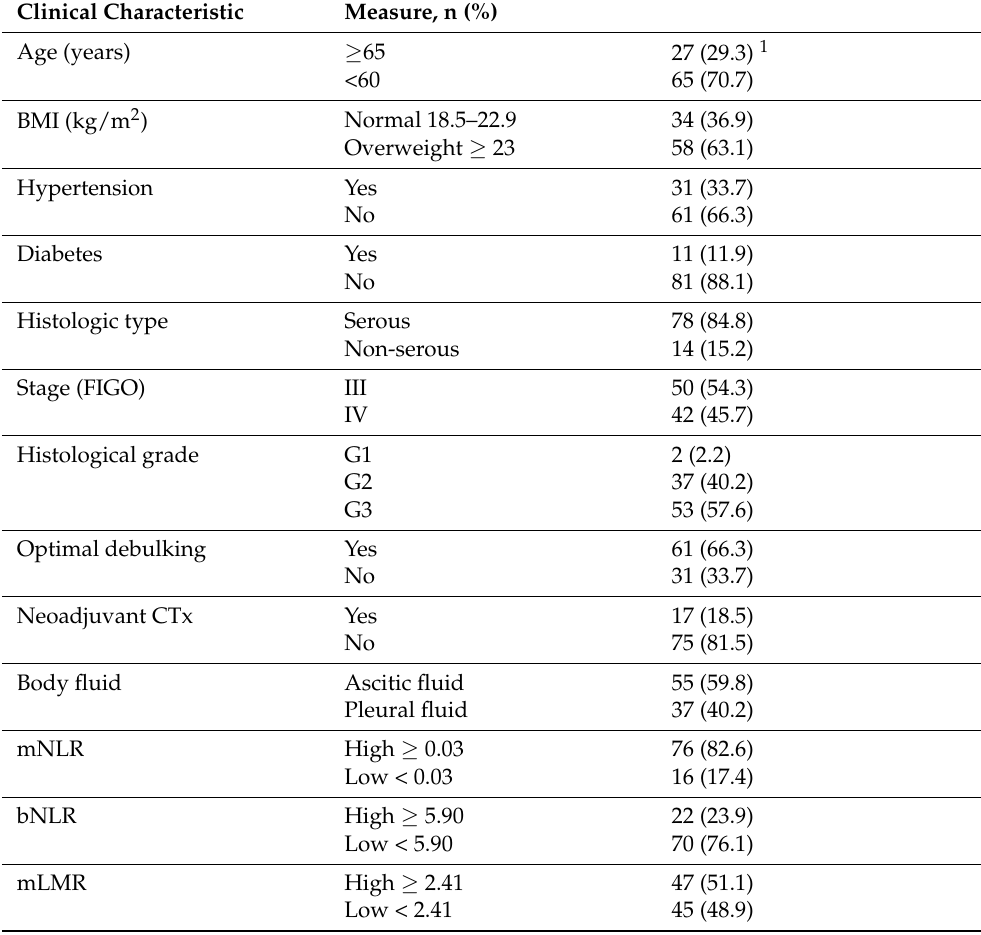
Table 1. Baseline patient’s characteristics (n =